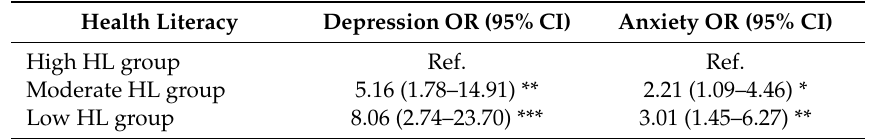
Table 2. The association of HL with depression and anxiety adjusted for age and gender ( n = 479).